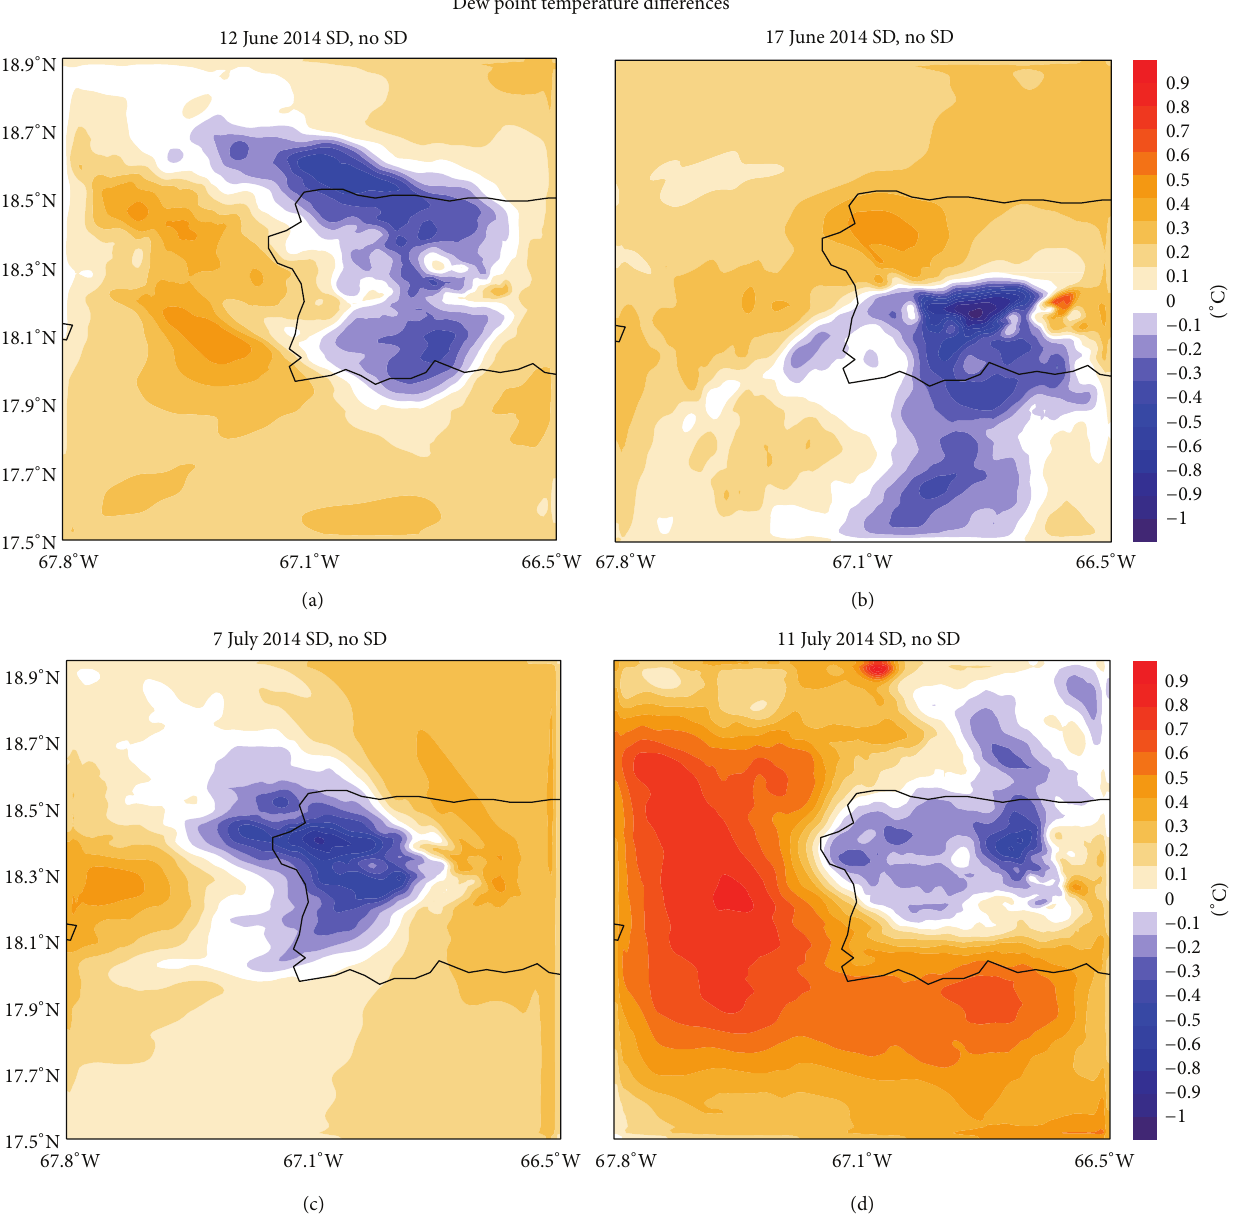
Figure 9: RAMS generated dew point temperature differences between SD and no SD run for 12 June 2014 (a), 17 June 2014 (b), 7 July 2014 (c), and 11 July 2014